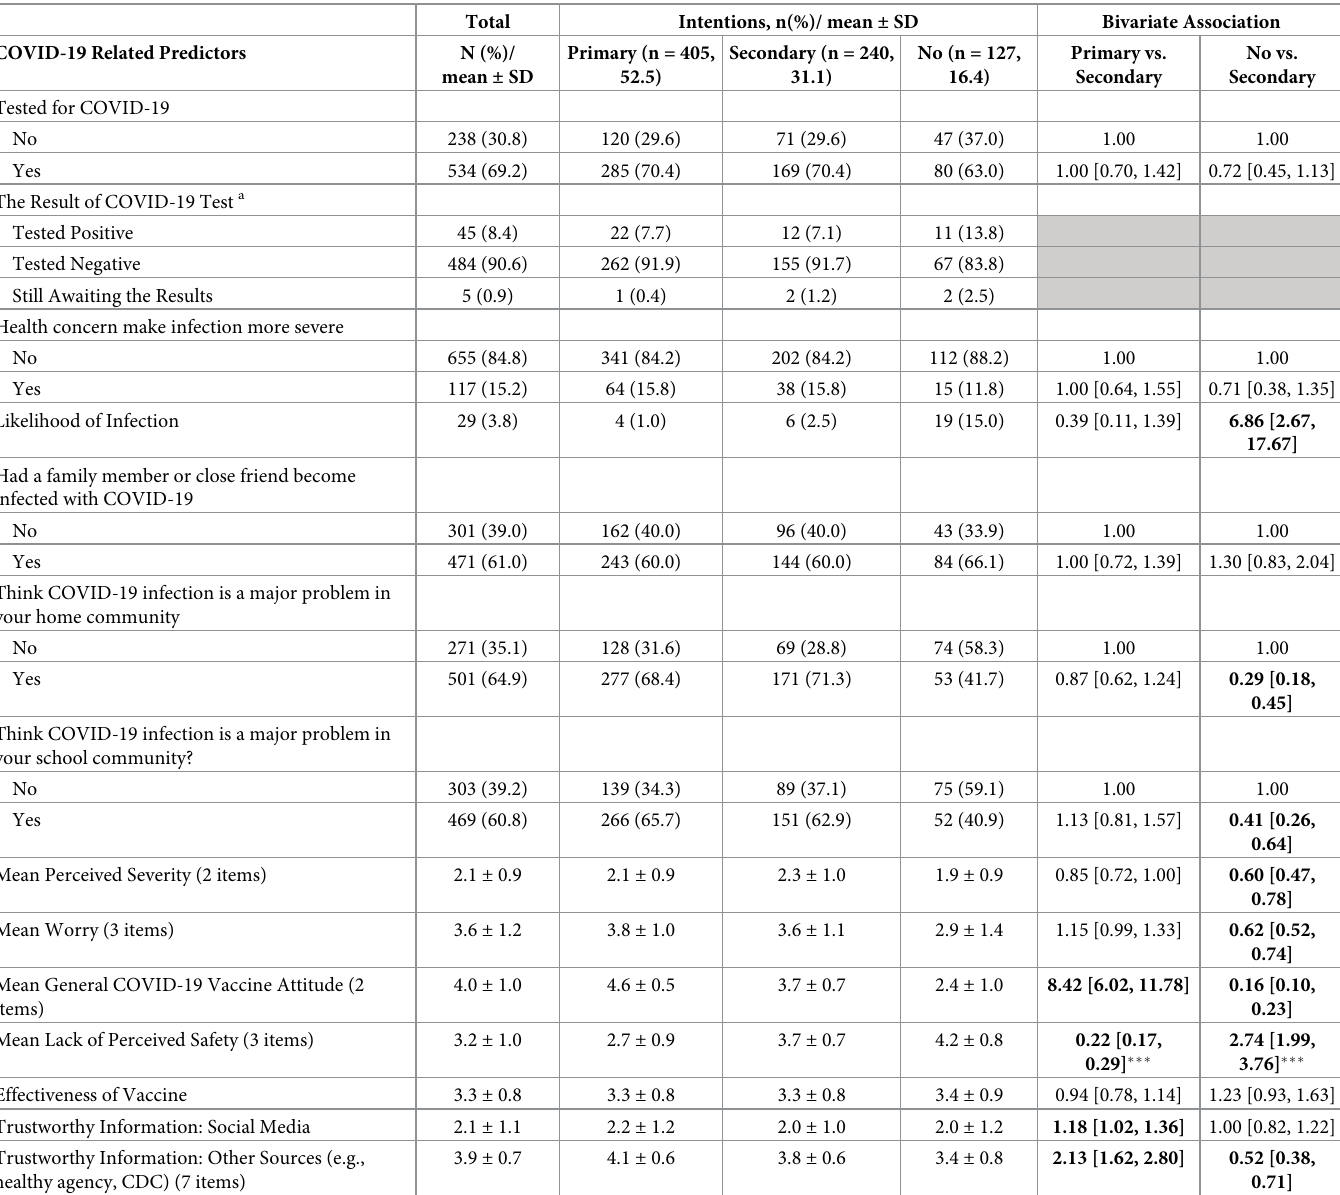
Table 2. COVID-related predictors, vaccine intentions, and bivariate association between COVID-19 related predictors and COVID-19 vaccine